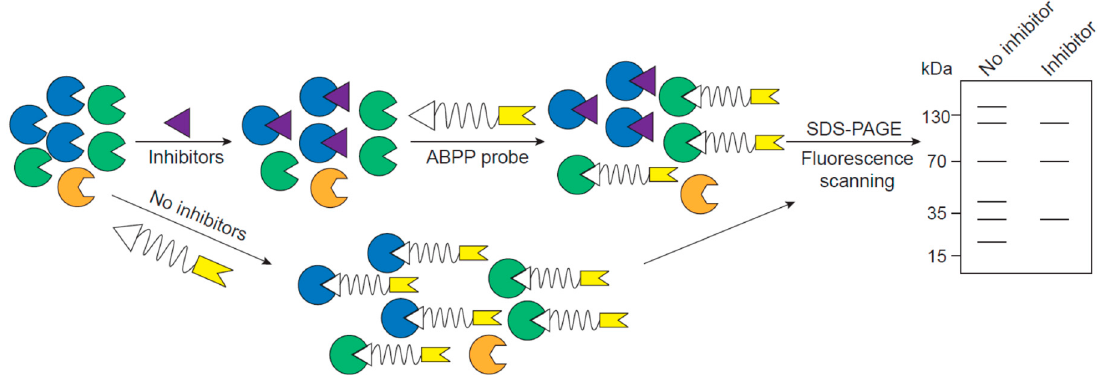
Figure 3. Experimental scheme to identify protease inhibitors and their target enzymes using ABPP. An ABPP competition experiment involves addition of potential inhibitors of interest followed by labeling remaining enzymes with an ABPP. Through a comparison of a sample treated with only probe, one can identify specificity and targets of potential protease inhibitors.